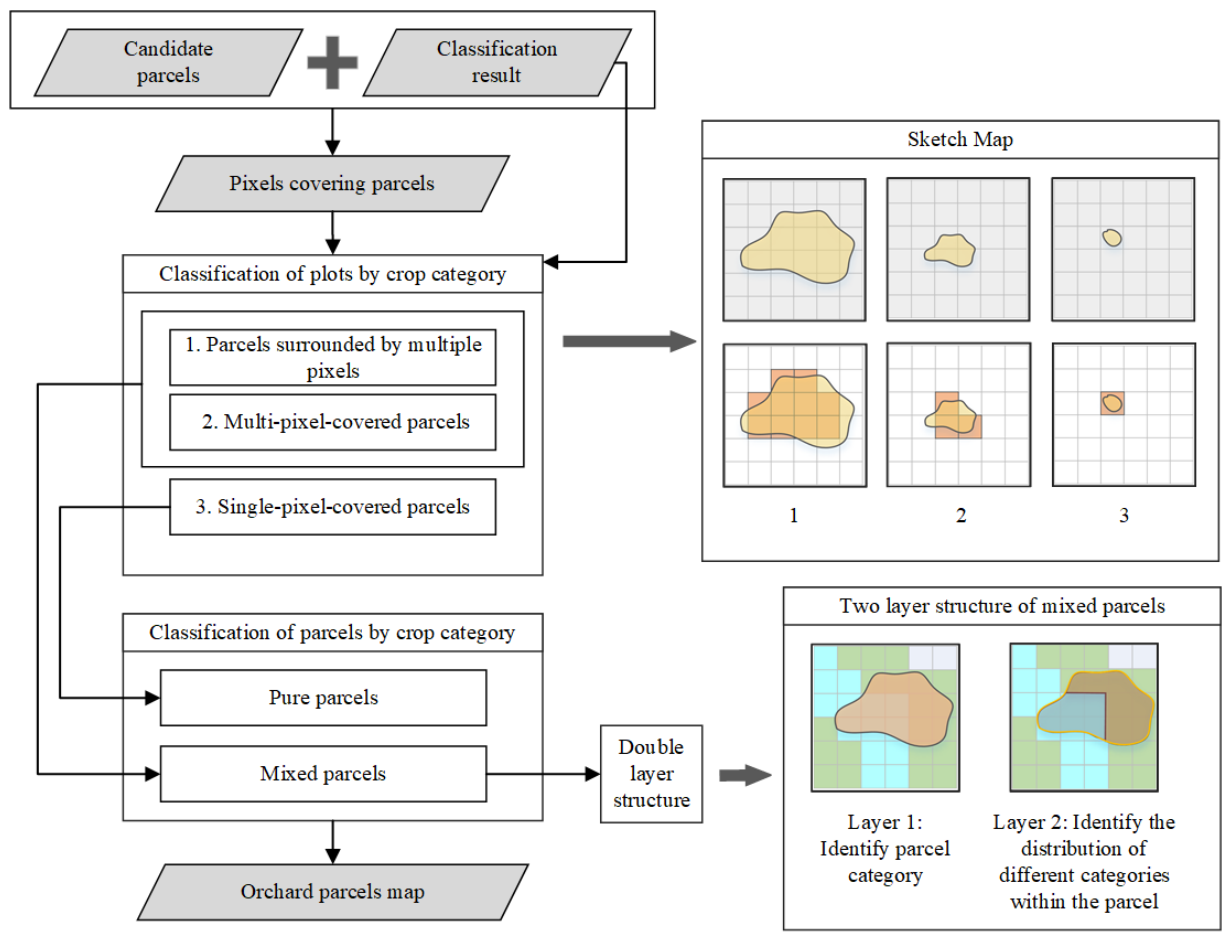
Figure 7. Parcel category filling